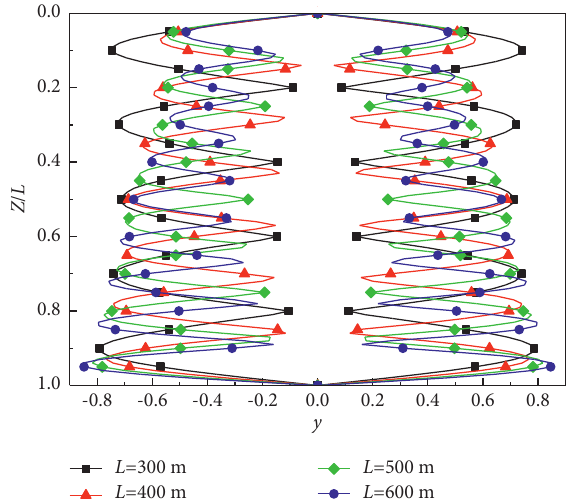
Figure 14: The VIV amplitude envelope of riser under different riser